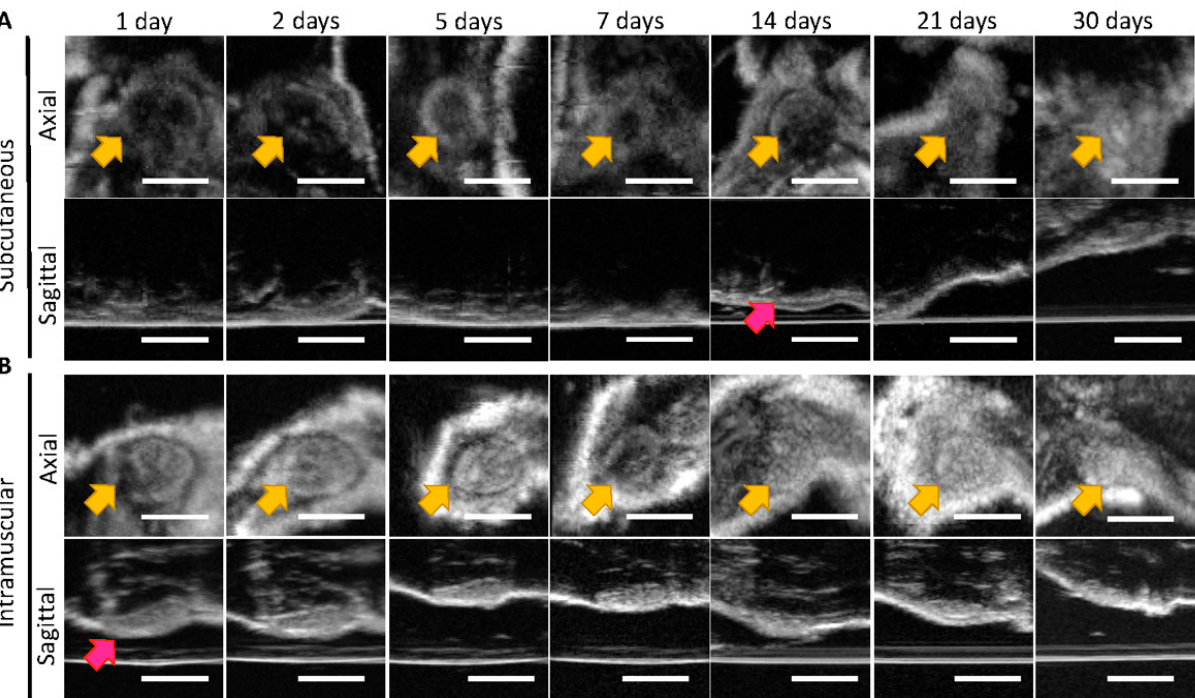
Figure 3. Representative B mode ultrasound images: ( A ) SQ ( B ) IM of axial and sagittal views of 40 μ L placebo ISFI (1:2 w / w PLGA/NMP) ISFIs injected into female NSG mice ( n = 5) taken over 30 days. Yellow arrows show ISFIs in the axial, and the timepoint at which the ISFI flattens is shown by the pink arrows. Scale bar = 5 mm.